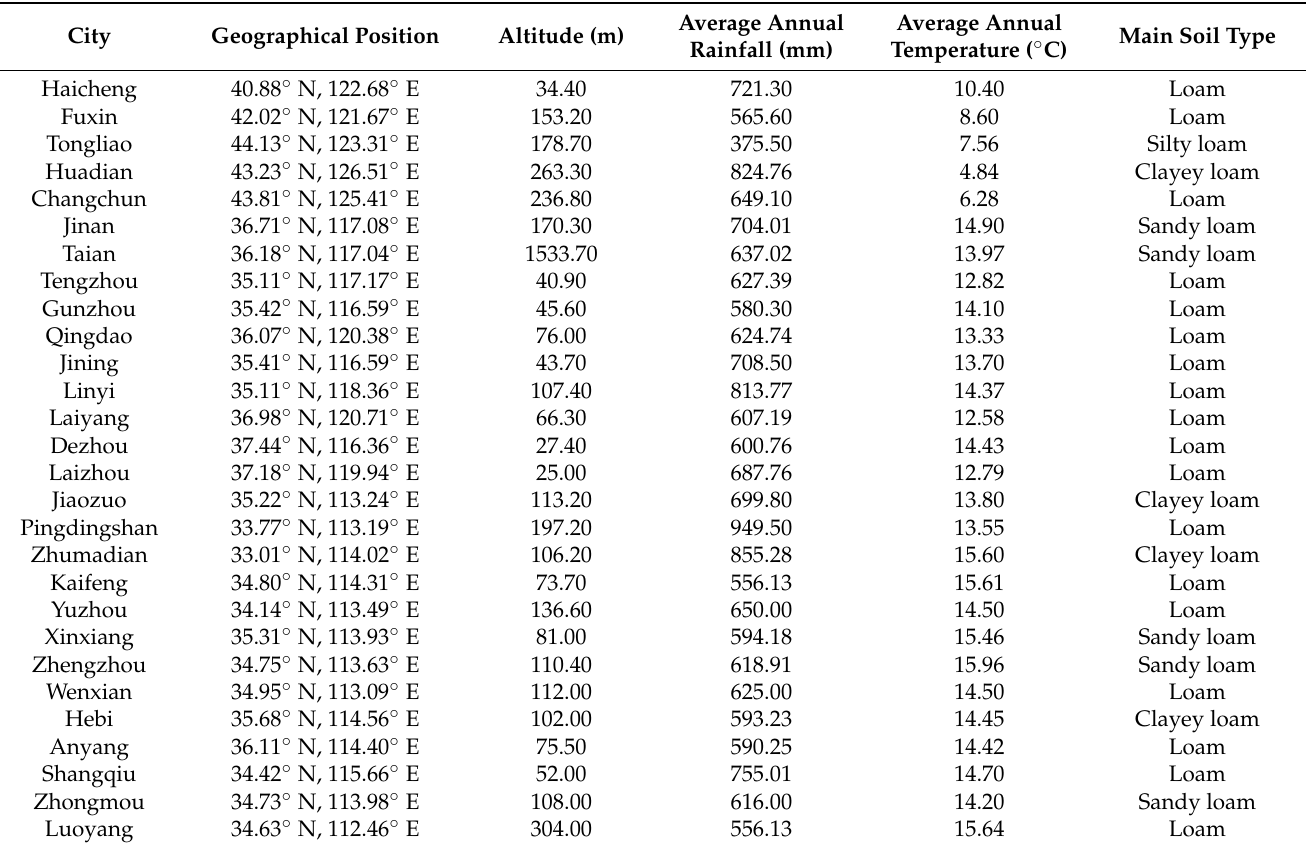
Table 3. Geographical Position and Main Characteristics of Each Site for Summer Maize in